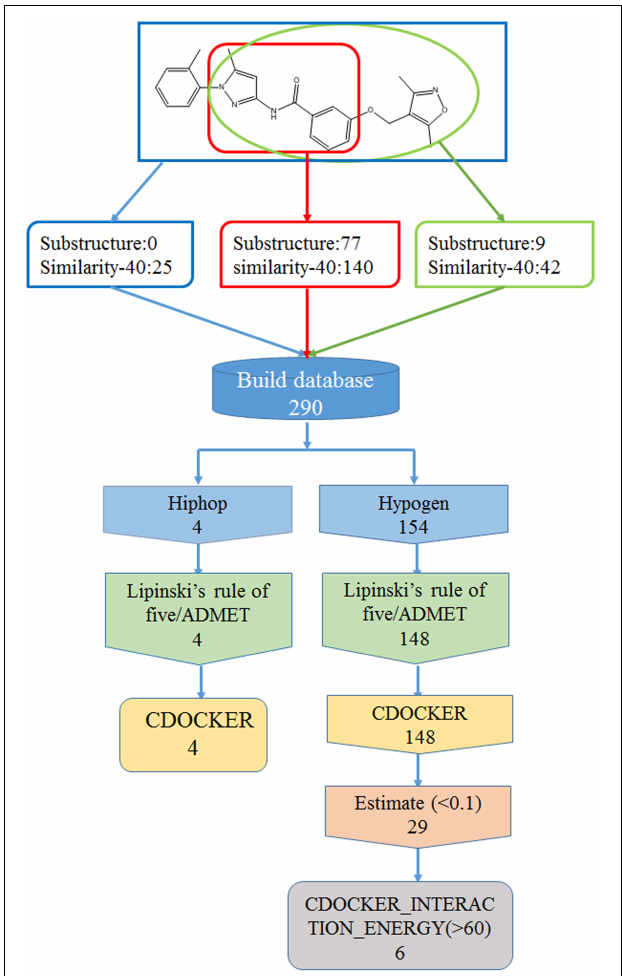
FIGURE 7 | The work flow chart of structure optimization and its screening